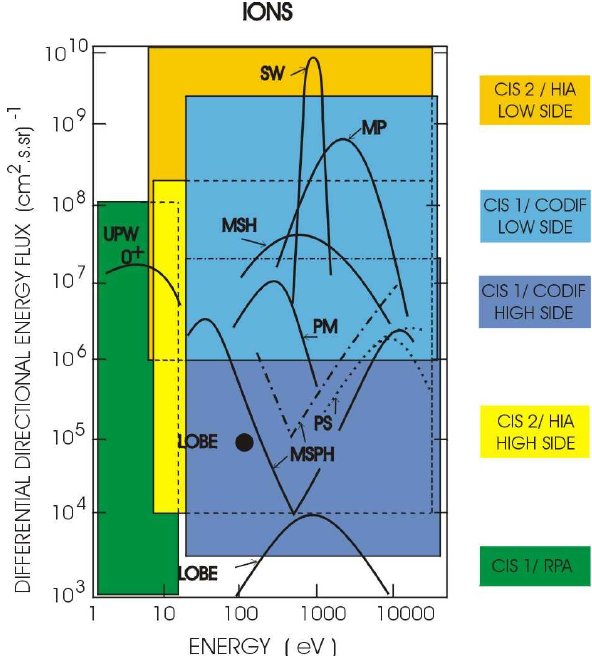
Fig. 1. Representative ion fluxes encountered along the Cluster orbit in the solar wind (SW), the magnetopause (MP), the magnetosheath (MSH), the plasma mantle (PM), the magnetosphere (MSPH), the plasma sheet (PS), the lobe and upwelling ions (UPW). The range of the different sensitivities of CIS1/CODIF (Low Side, High Side and RPA) and CIS2/HIA (Low g and High G ) are shown with different